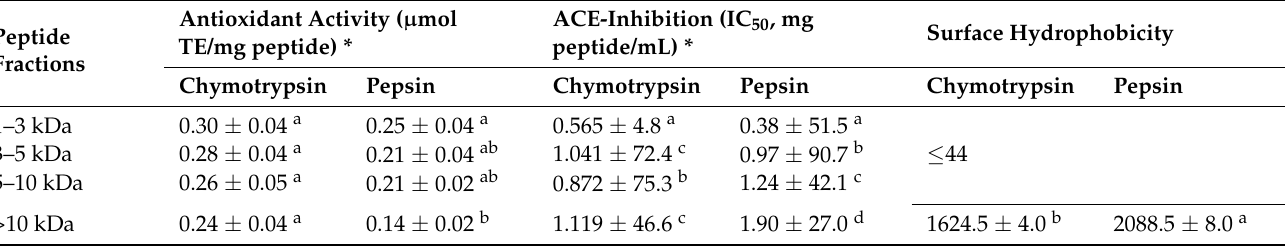
Table 1. Bioactivity and surface hydrophobicity of WPI peptide